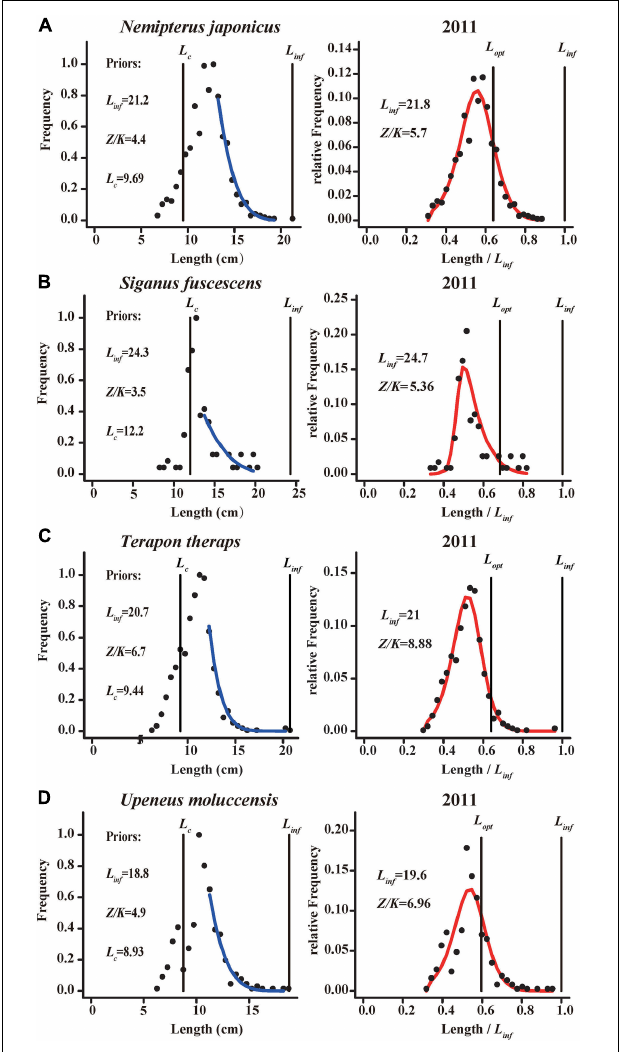
FIGURE 3 | The assessment results of four “grossly overfished” species with LBB method in Beibu Gulf. (A–D) Presents the result of Nemipterus japonicus